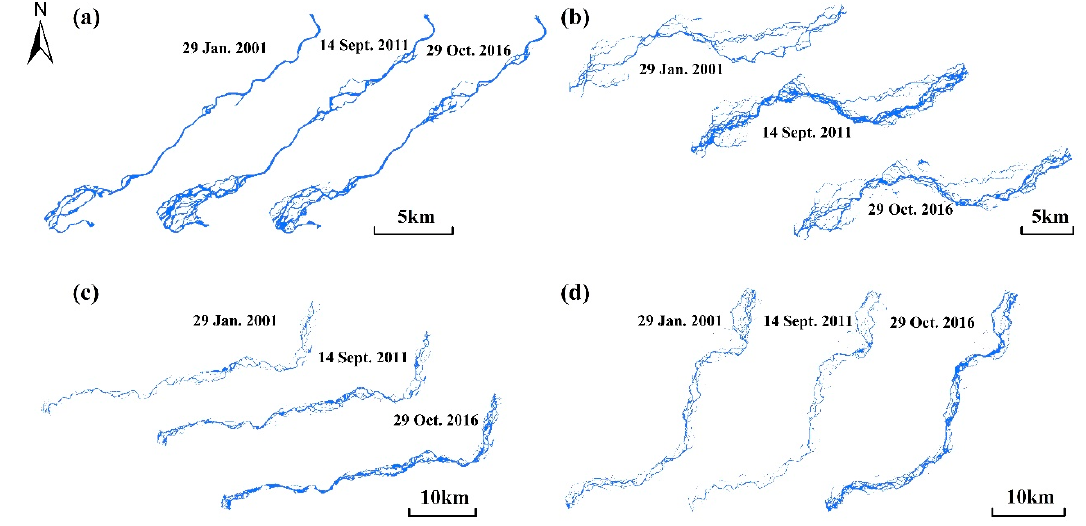
Figure 5. Morphological change of braided channel in four reaches along the channel in 2001, 2011 and 2016 ( a ) RS1; ( b ) RS2; ( c ) RS3; ( d ) RS4. 2016 ( a ) RS1; ( b ) RS2; ( c ) RS3; ( d )